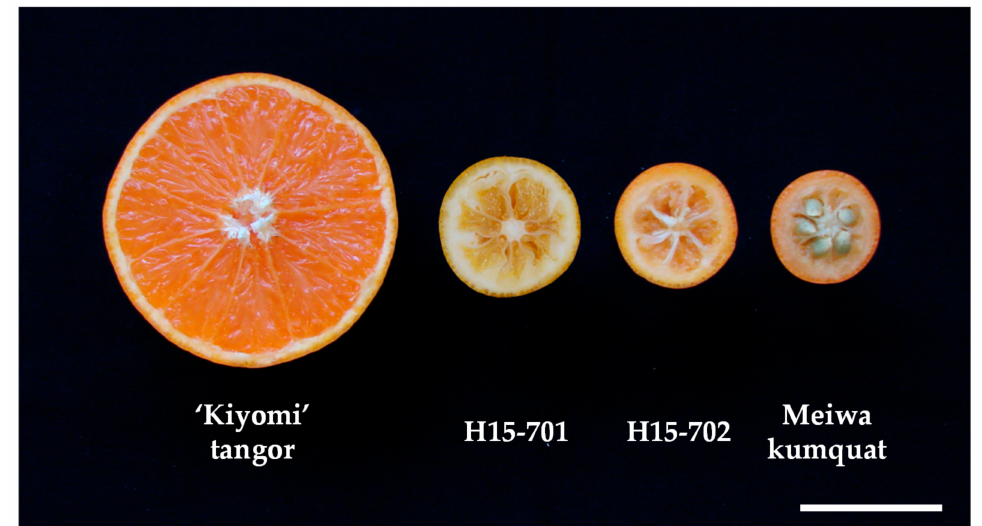
Figure 9. Comparison of morphological characteristics of fruits in ‘Kiyomi’ tangor, Meiwa kumquat, and their hybrids by cross section of mature fruits. Bar = 5.0